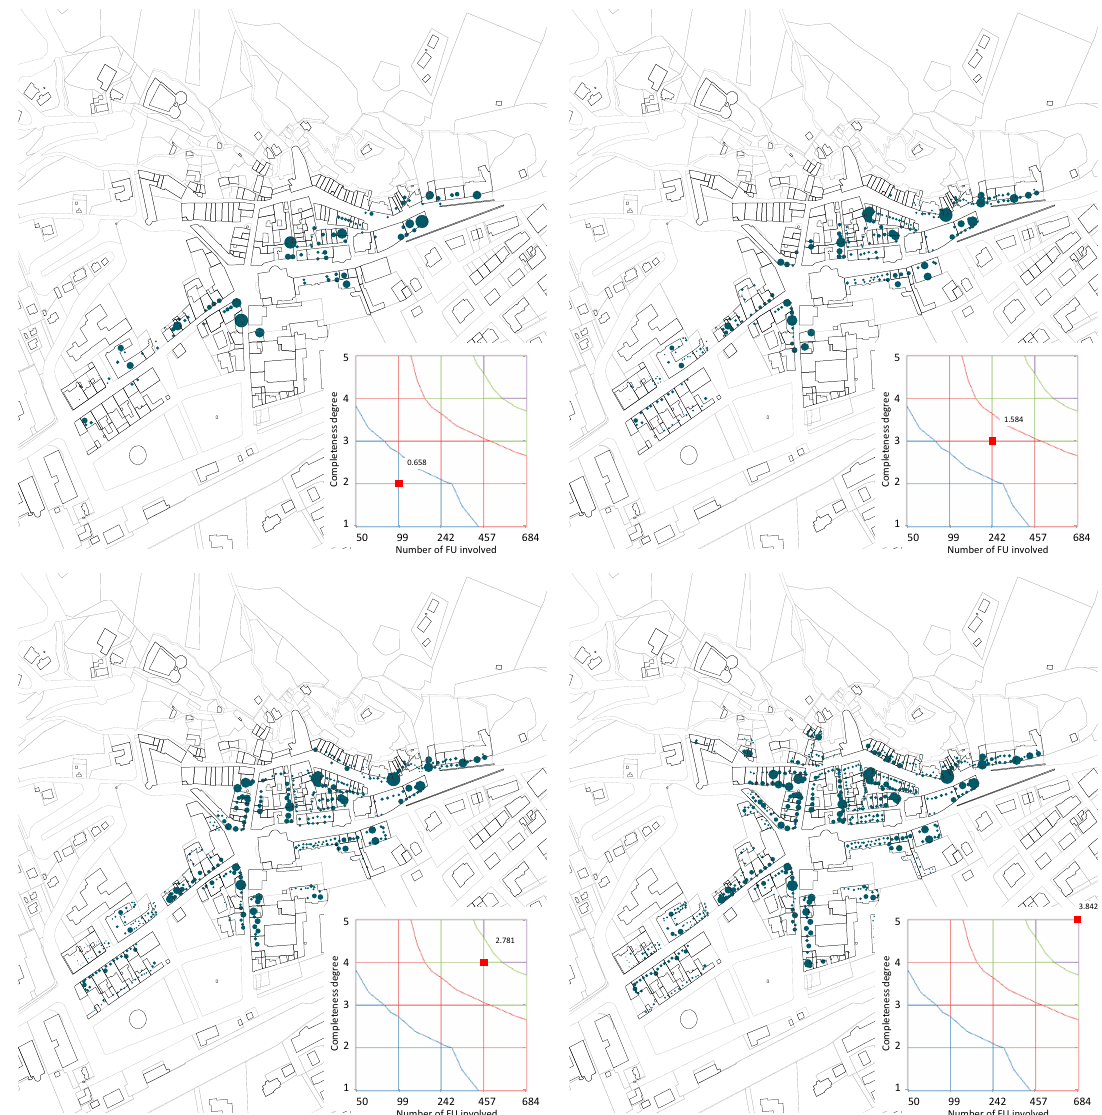
Figure 4. Mapping of the different layouts of the strategies having an increasing total cost. In Figure 5, instead, the strategies displayed are those having approximately the same cost so that they differ regarding the completeness and security degree.